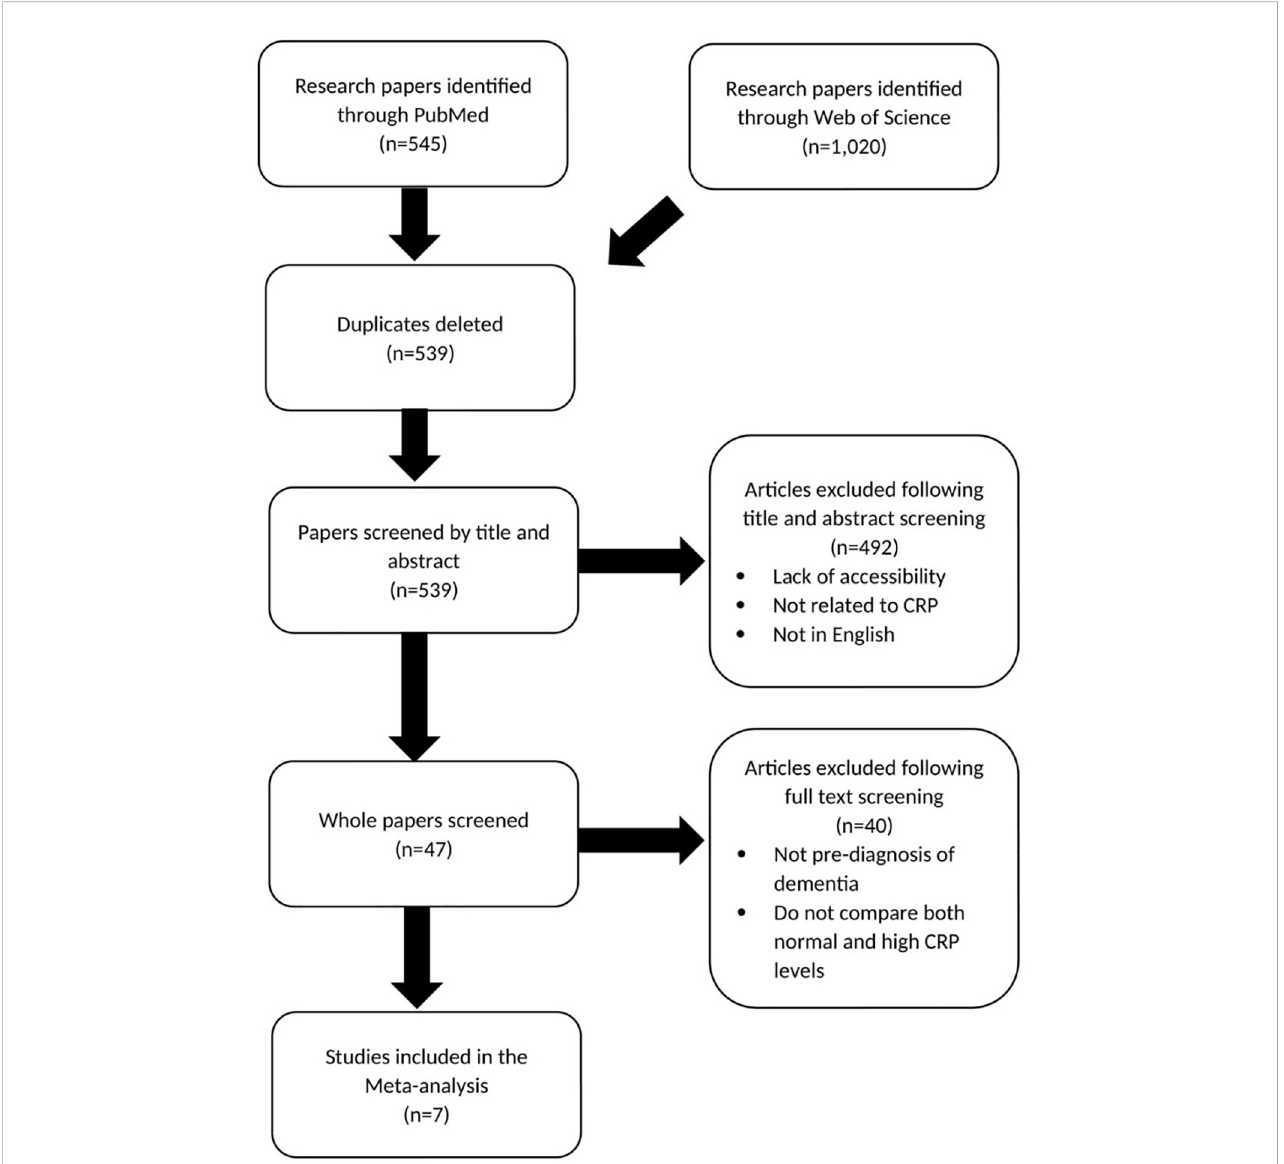
FIGURE 2 Prisma chart showing paper selection for meta-analysis investigating CRP association with dementia